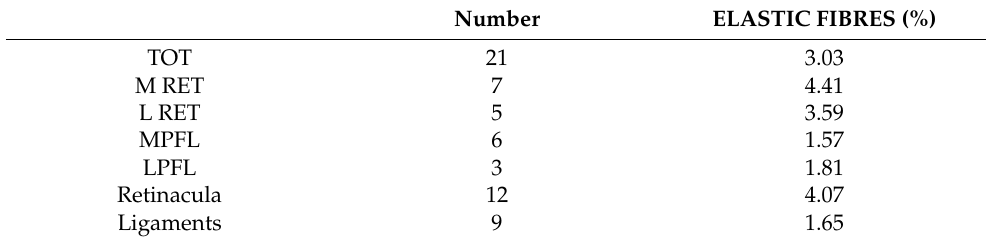
Ligaments (RET M: medial retinaculum; RET L: Lateral retinaculum; MPFL: Medial patellofemoral ligament; LPFL: Lateral patellofemoral ligament).